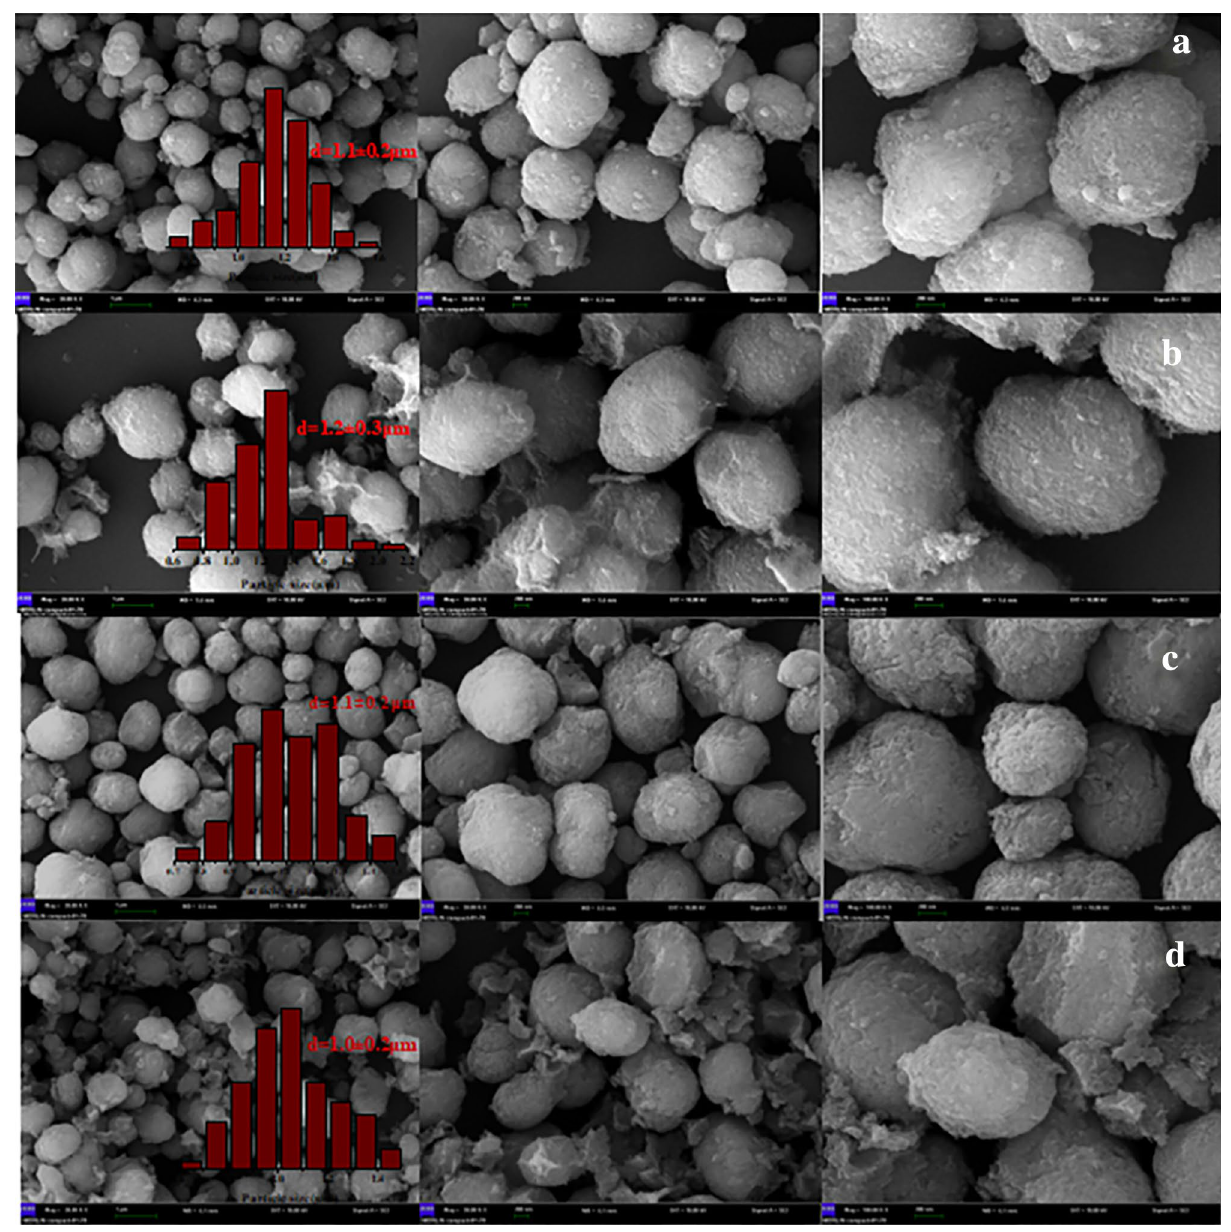
Figure 3. SEM of FMTP ( a ); FMTP-4 mol/L H 2 C 2 O 4 ( b ); FMTP 4 mol/L H 2 C 2 O 4 + 0.2 mol/L NaOH ( c ) and adsorbent product ( d ).